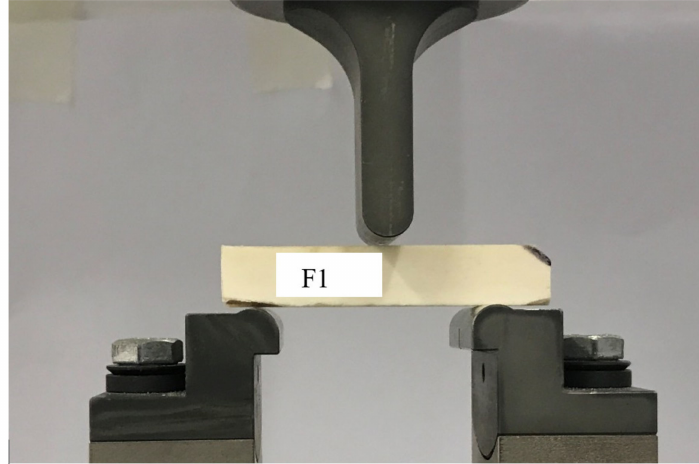
Figure 4. Sample prepared to perform three-point